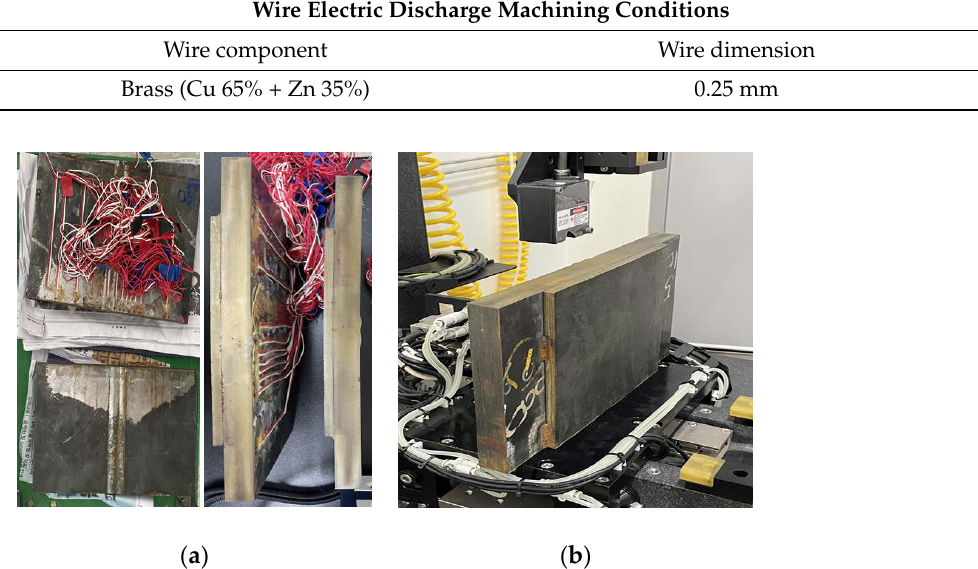
Table 6. Wire electric discharge machining conditions.